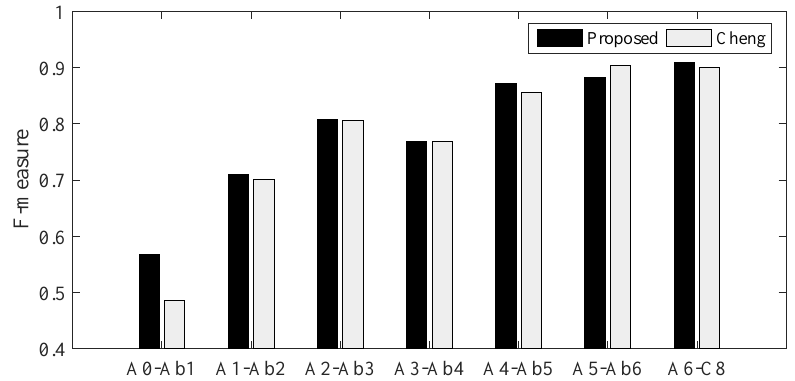
Figure 9. F-measure per octave achieved by our proposed system and Cheng’s